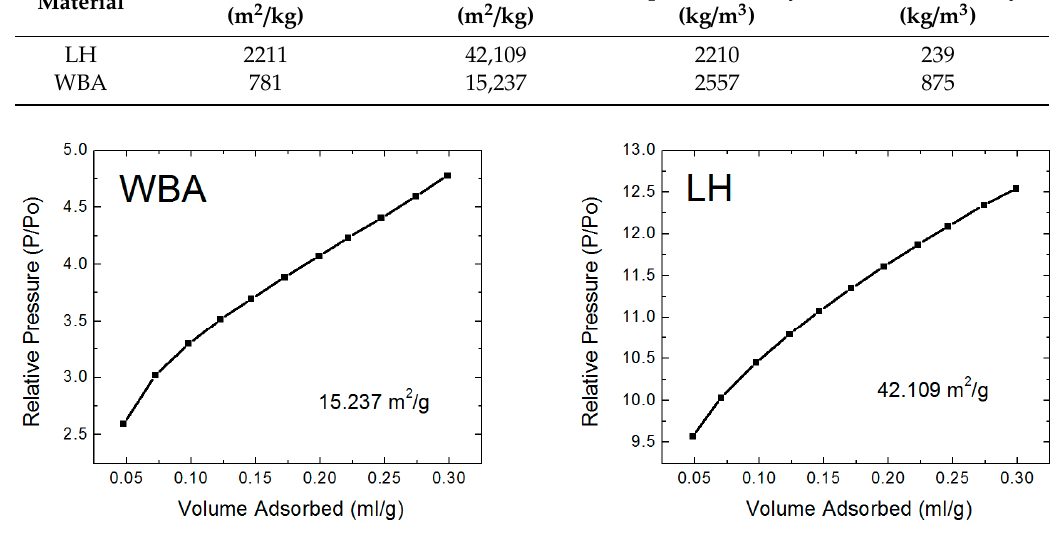
Figure 1. Surface area of WBA and LH measured by a sorption analyzer.